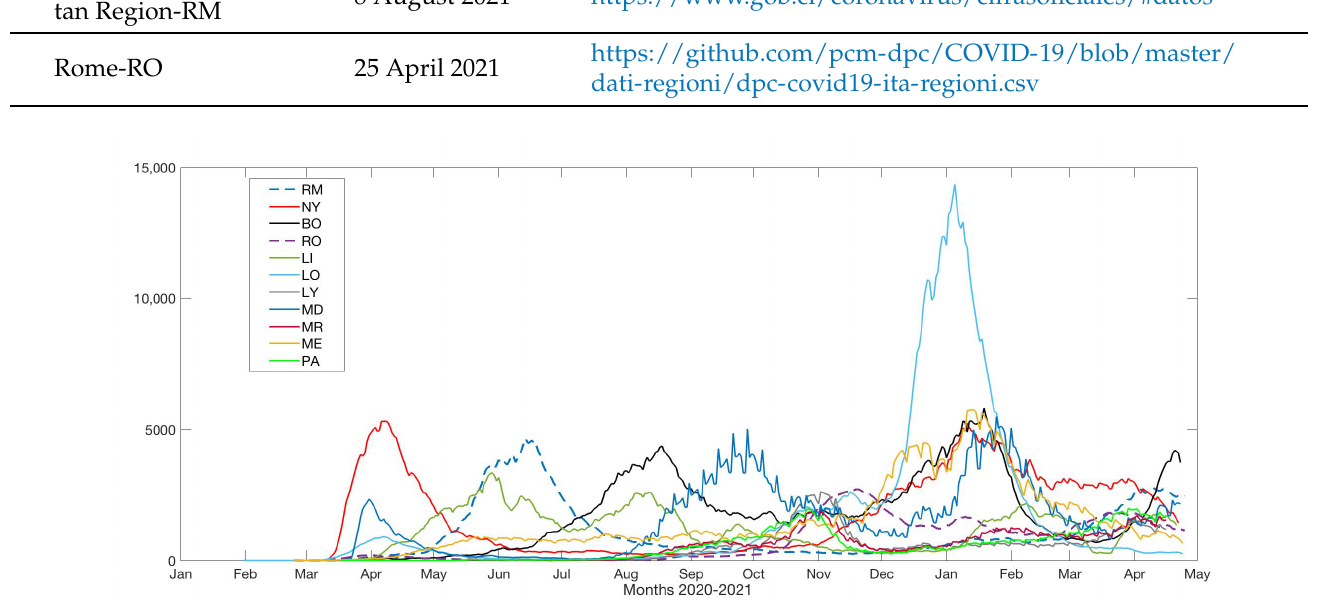
Figure 1. Daily changes of coronavirus disease 2019 cases in different cities during